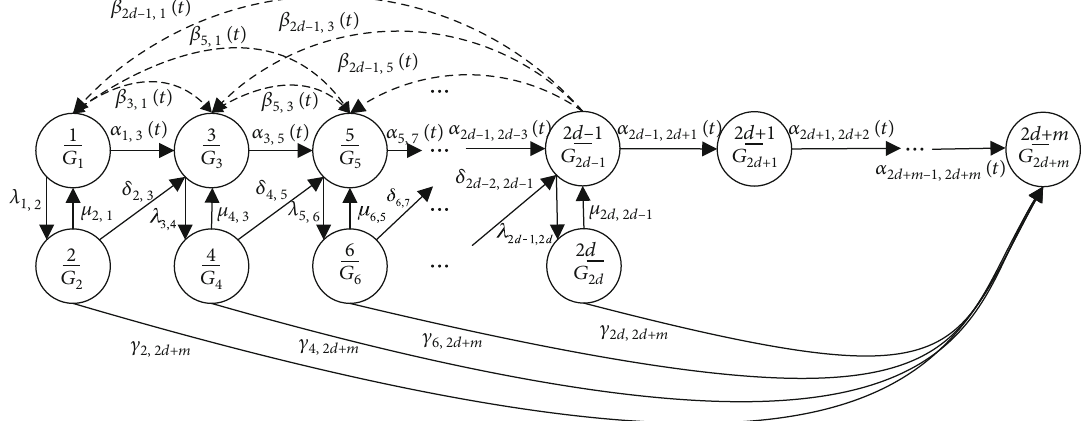
Figure 2: Transition diagram of repairable multistate assembly.